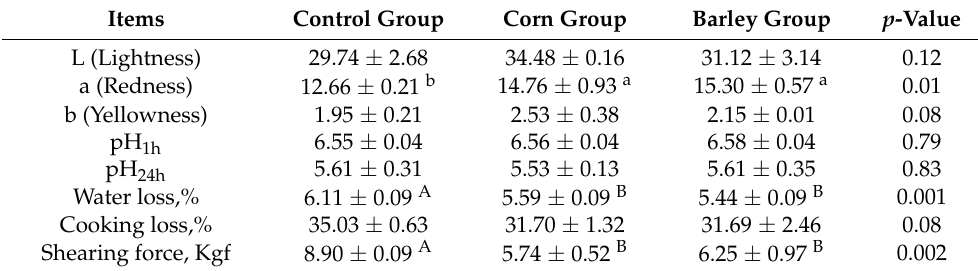
Table 6. Effects of different carbohydrate source diets on beef